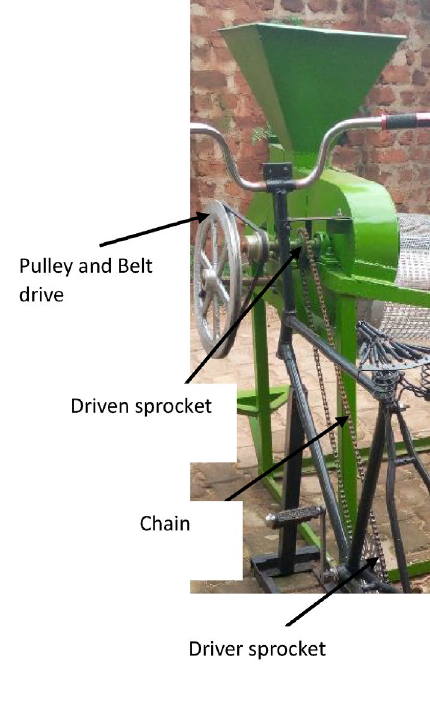
Fig. 3 The drive